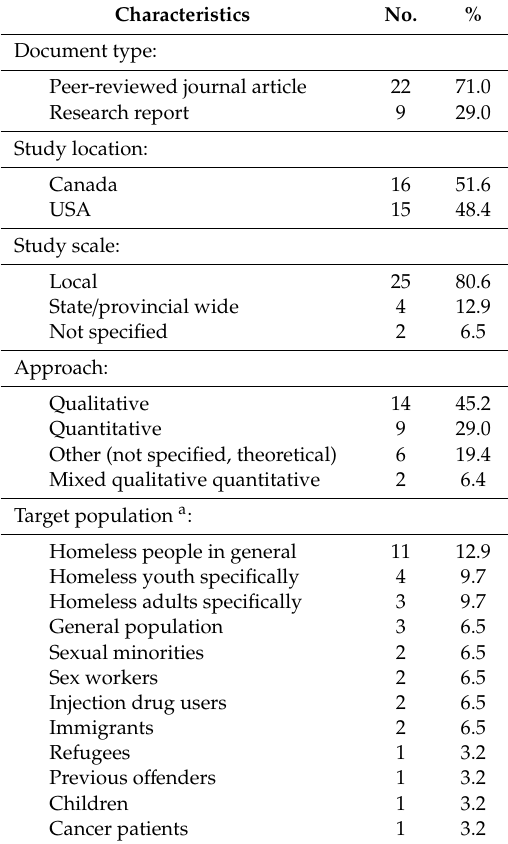
Figure 1. Flow chart of the selection of studies on barriers to and facilitators of obtaining identification in North America. Table 2. Summary of the descriptive characteristics of 31 studies on the barriers to and facilitators of obtaining identification in North America.